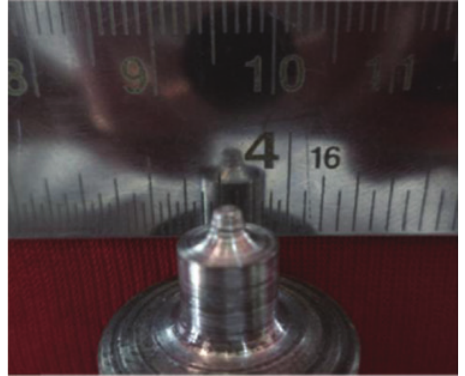
Figure 3: Photograph of fabricated FSW tool.